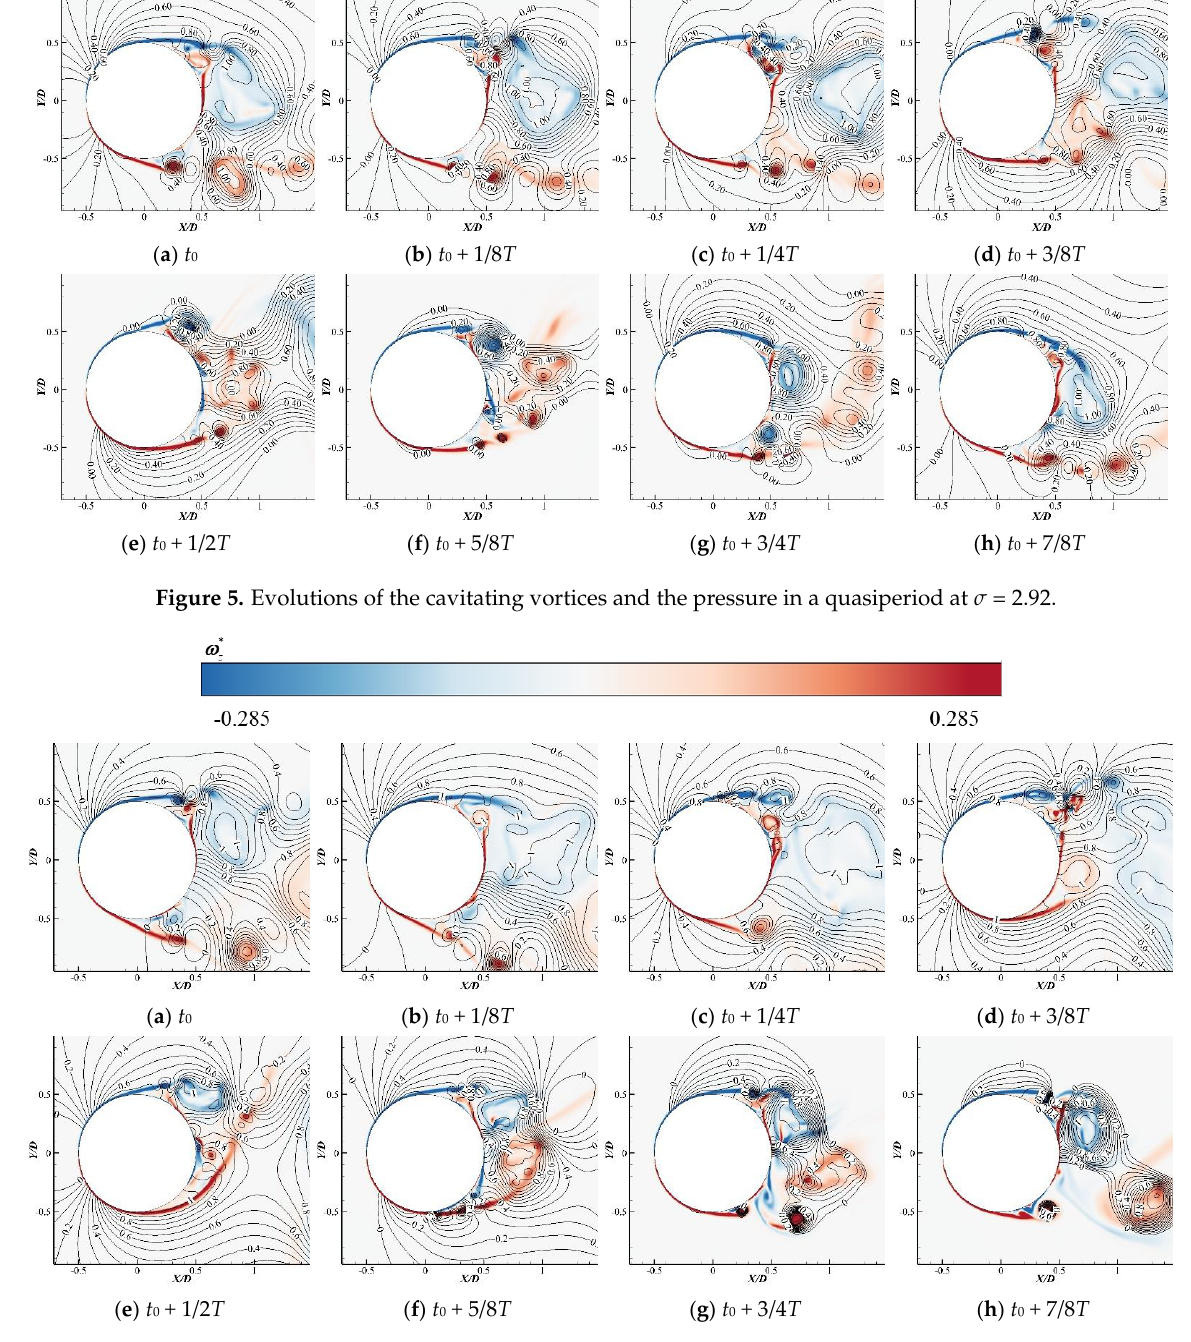
Figure 6. Evolutions of the cavitating vortices and the pressure in a quasiperiod at σ = 2.52.